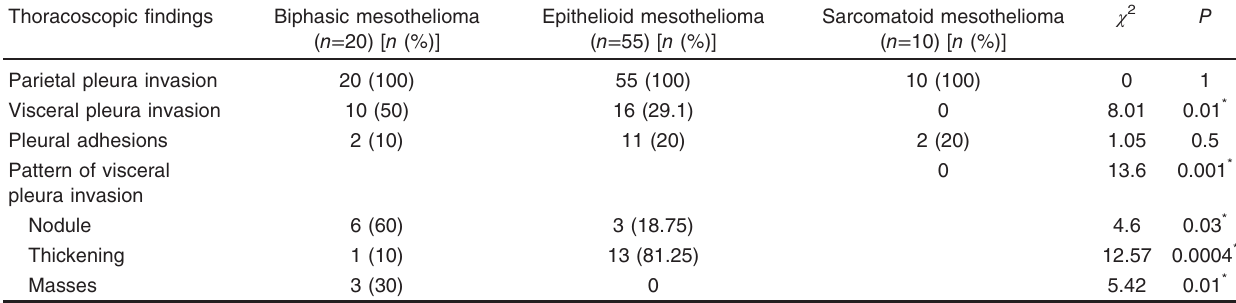
Table 1 Relation between thoracoscopic findings and type of mesothelioma Thoracoscopic